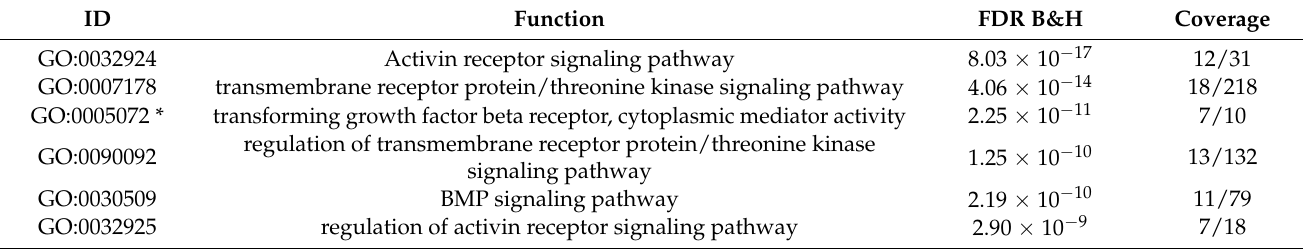
Table 1. GO terms associated with upregulated genes by Activin-A in FOP cells. ID Function